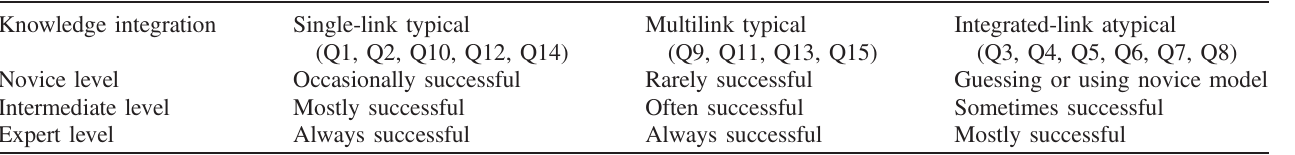
TABLE I. Question designs for assessment of knowledge integration